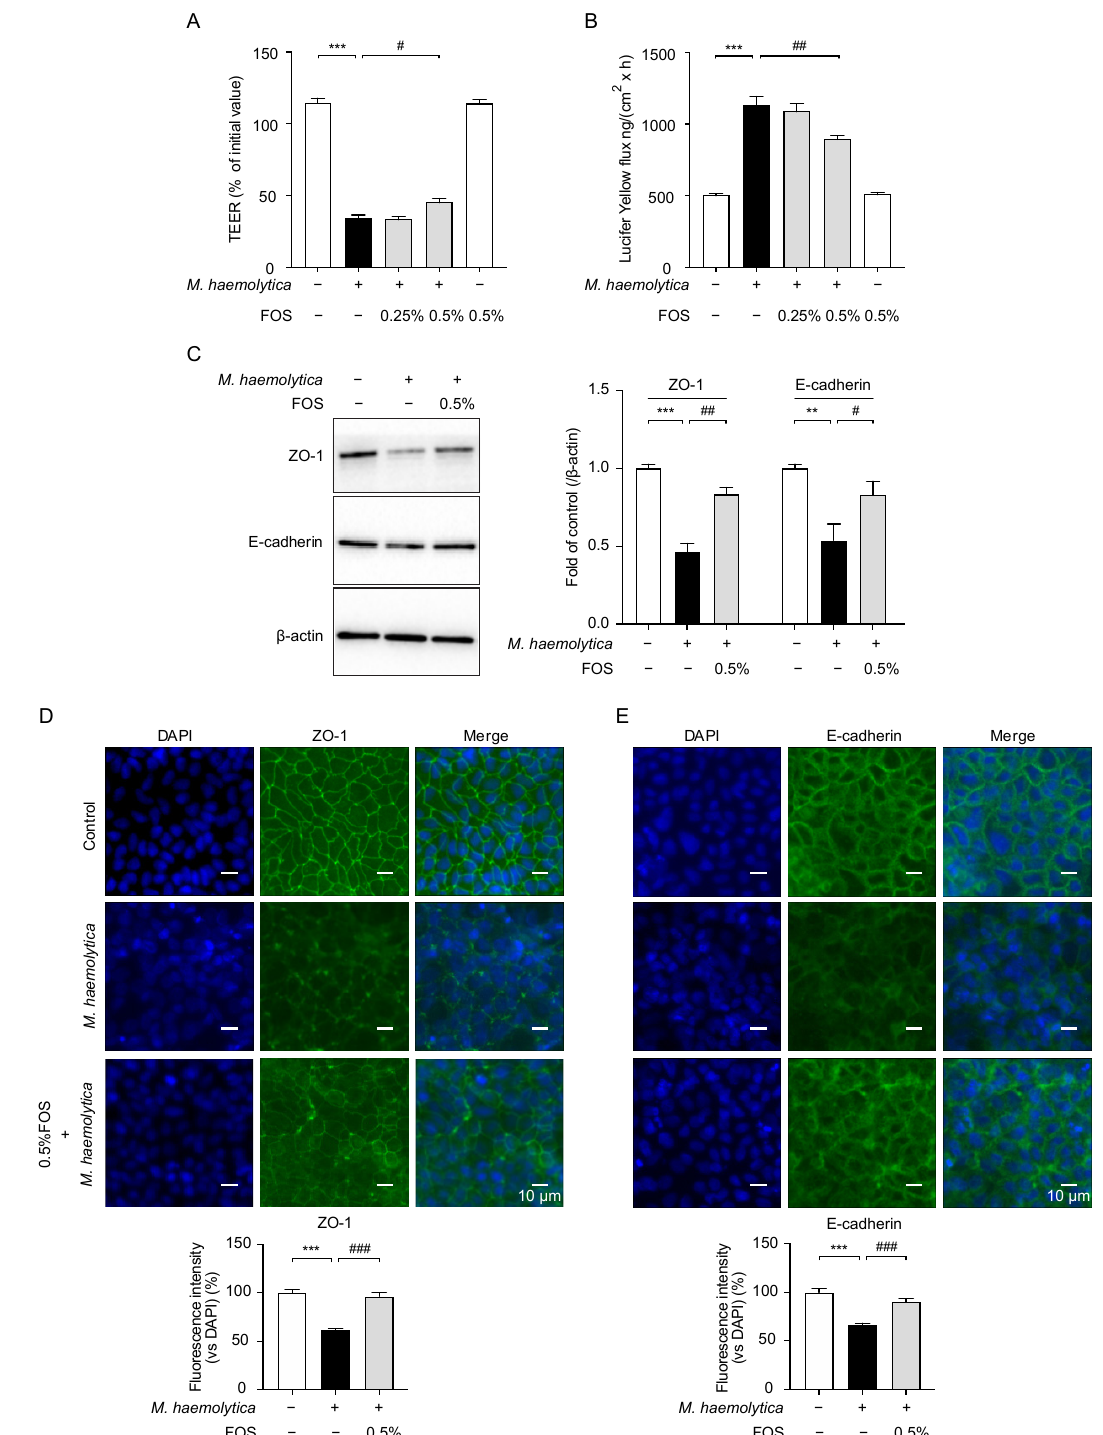
Figure 5. Effect of FOS on M. haemolytica -induced barrier dysfunction in PBECs. ( A ) TEER was measured and ( B ) lucifer yellow flux from apical to basolateral compartment was determined in PBECs. ( C ) The immunoblots were obtained with ZO-1, E-cadherin, and β -actin (protein loading control). ( D , E ) Cellular expression of ZO-1 and E-cadherin in PBECs was assessed by immunofluorescent staining and quantified as a percentage of fluorescence intensity. Significantly different from control: ** p < 0.01; *** p < 0.001. Significantly different from M. haemolytica : # p < 0.05; ## p < 0.01; ### p < 0.001. Data are presented as means ± SEM. All data shown are representative of at least five independent experiments ( n = 5–6 donor calves, one donor calf per experiment). DAPI, 4 ′ , 6-diamidino-2-phenylindole; FOS, fructo-oligosaccharides; TEER, transepithelial electrical resistance; ZO-1, zonula occludens-1.